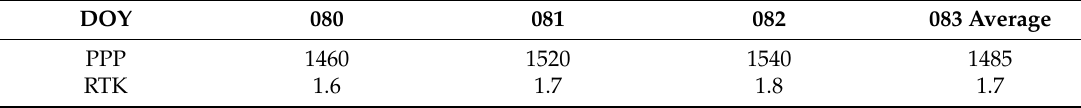
Table 4. The statistics of the average convergence time (Unit: s).